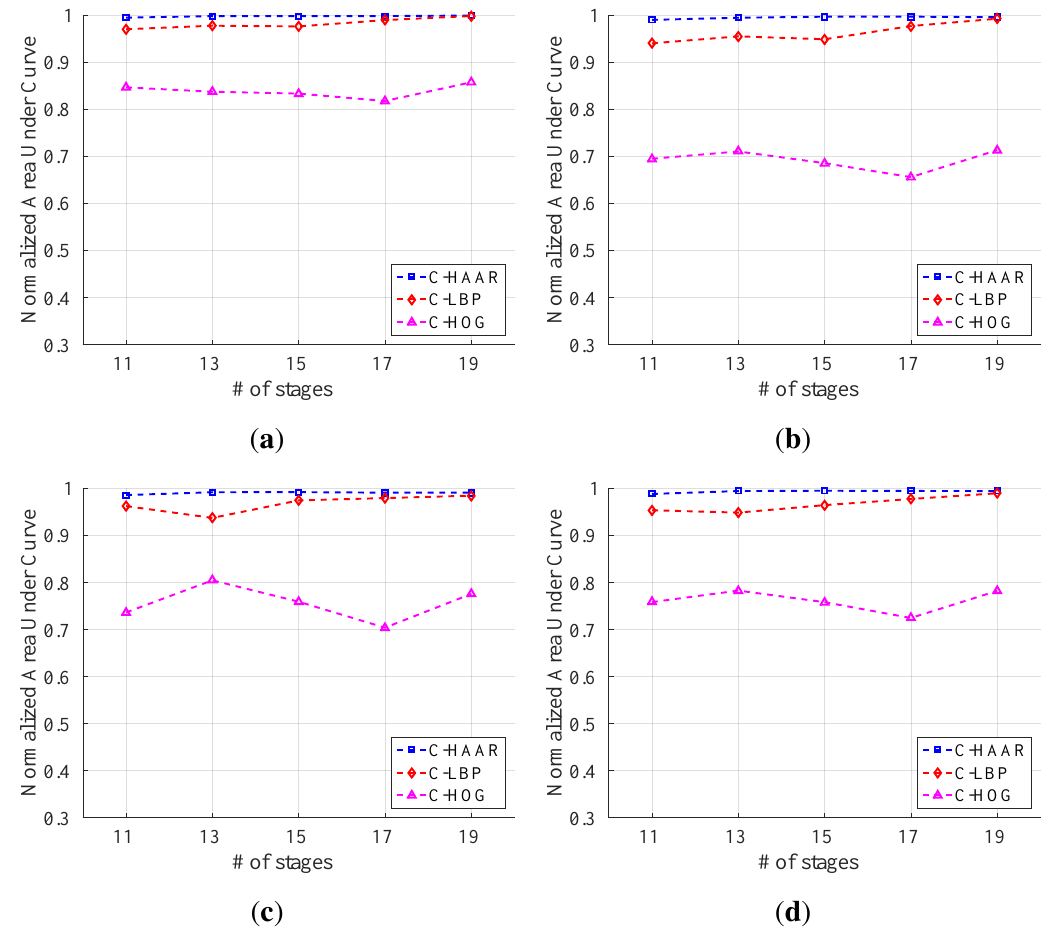
Figure 14. Normalized area under the curves for outdoor evaluation. ( a ) Stationary background calm flight; ( b ) stationary background agile flight; ( c ) moving background calm flight; ( d ) all outdoor flights